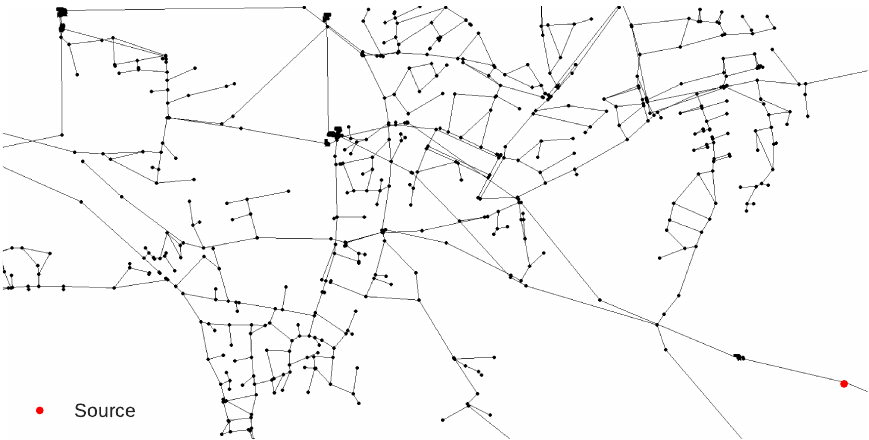
Figure 9. Richmond water supply network contamination source location.